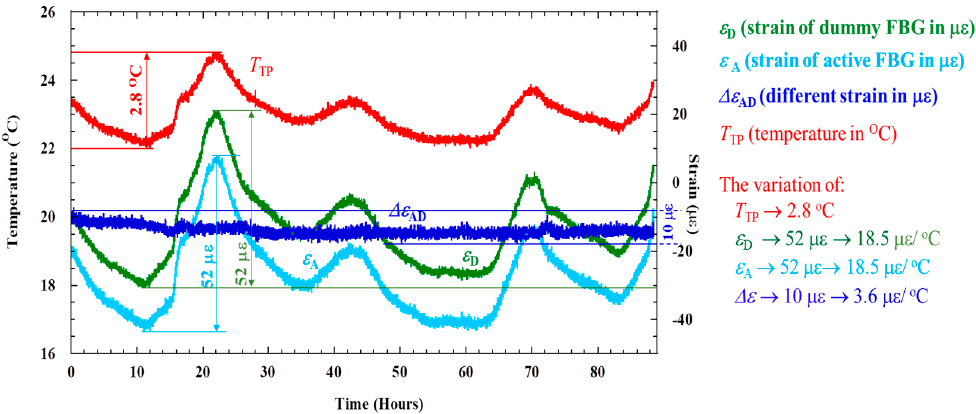
Figure 10. Variation in the sensor signal patterns in the absence of corrosion. Only Δε AD shows no dependence on temperature.